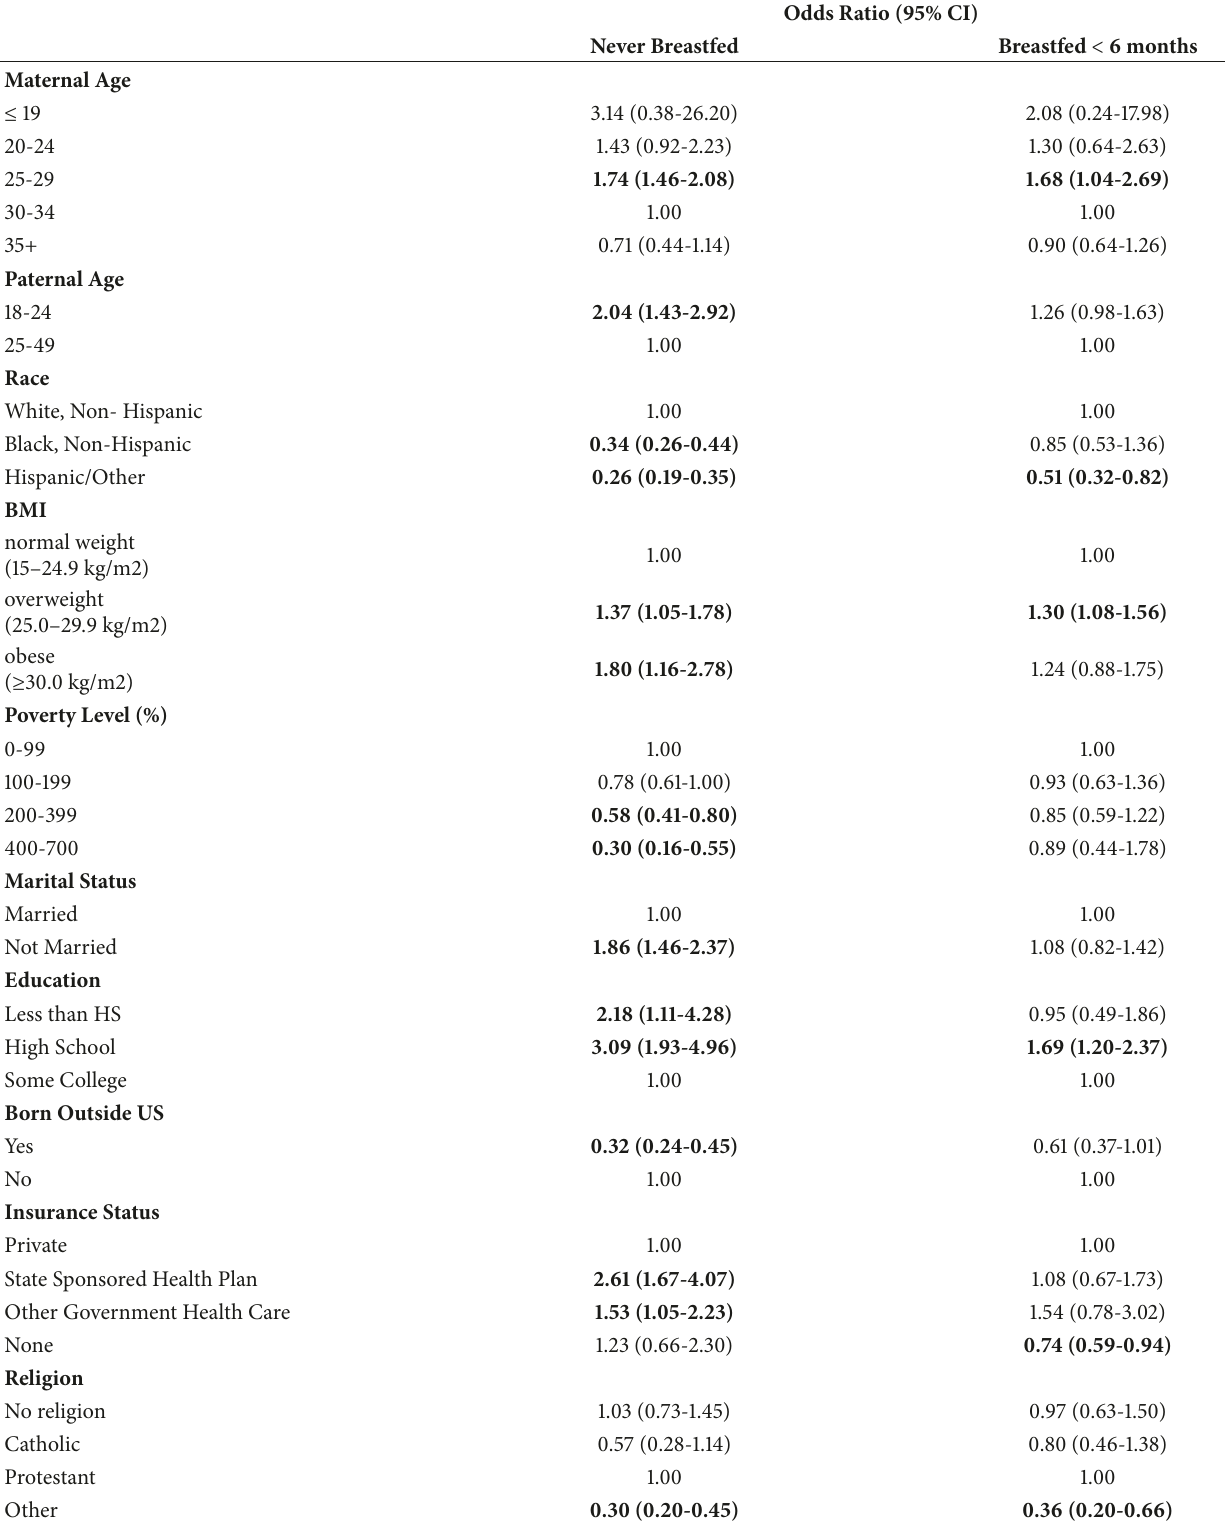
Table 2: Factors associated with breastfeeding duration among US mothers: NSFG